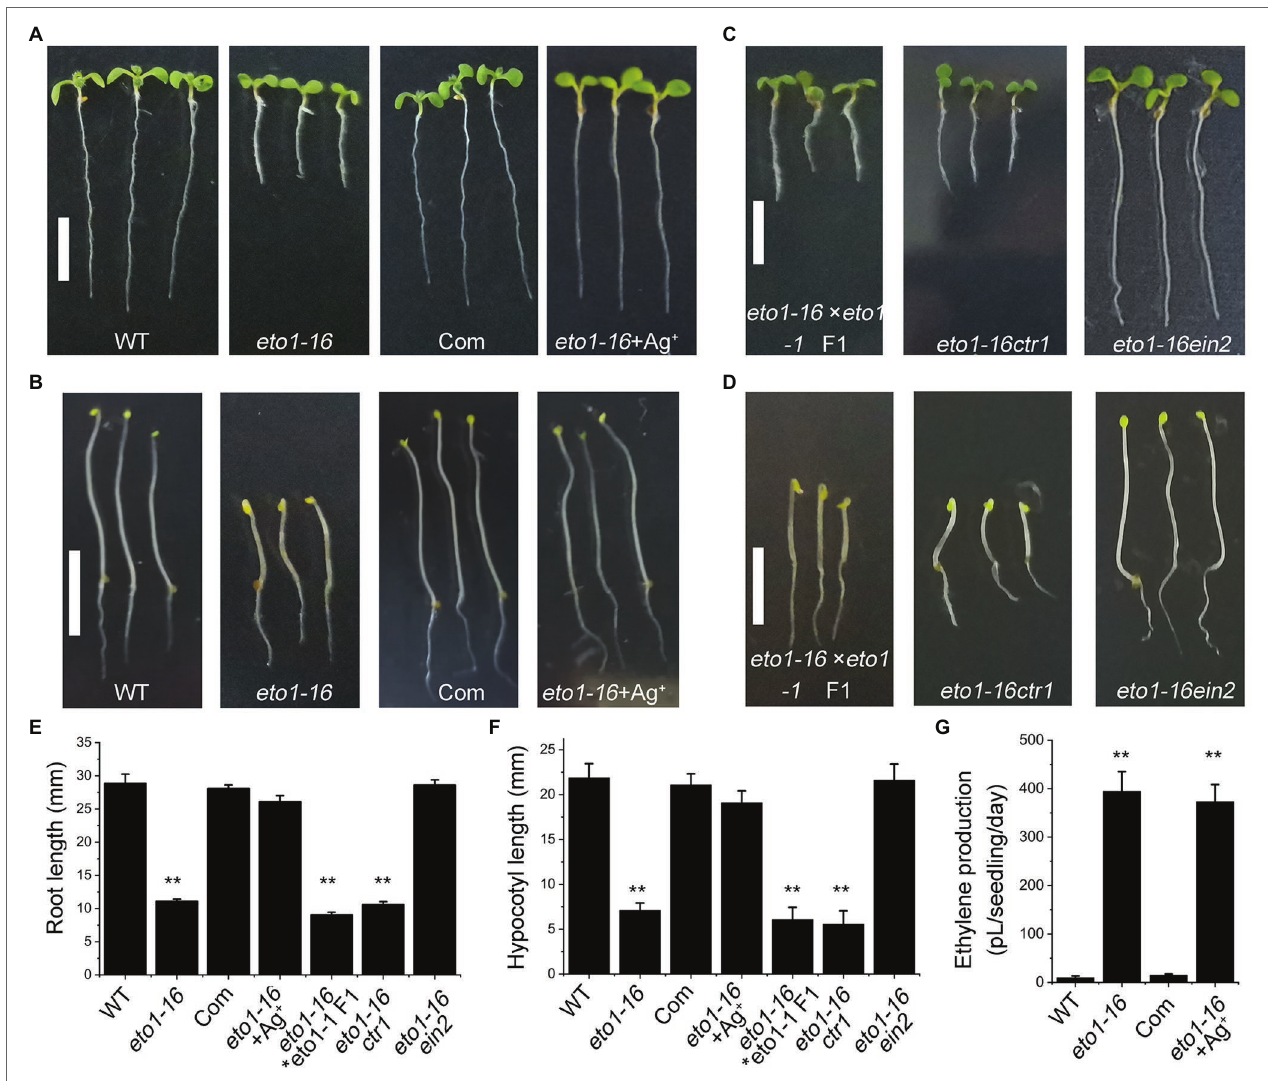
FIGURE 3 | Genetic and biochemical analysis of eto1-16 . (A) Root phenotypes of the WT, eto1-16 , complementary (Com) and eto1-16 (+Ag + ) plants. Scale bar = 10 mm. (B) Hypocotyl phenotypes of the WT, eto1-16 , Com, and eto1-16 (+Ag + ) plants. Scale bar = 10 mm. (C) Root phenotypes of F1 generation of cross line between eto1-16 and eto1-1 , and double mutants eto1-16ctr1 and eto1-16ein2 . Scale bar = 10 mm. (D) Hypocotyl phenotypes of F1 generation of cross line between eto1-16 and eto1-1 , and double mutants eto1-16ctr1 and eto1-16ein2 . Scale bar = 10 mm. (E) The root length of plants in (A,B) . (F) The hypocotyl length of plants in (C,D) . (G) Ethylene production in WT, eto1-16 , Com, and eto1-16 (+Ag + ) plants. Statistical analysis was performed using a two-tailed Student’s t -test (** p < 0.01). For each experiment, at least three repeats were carried out in ethylene production test, and 50 plants were used in root and hypocotyl phenotypes